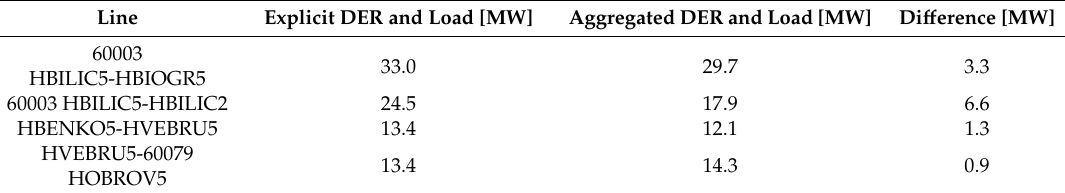
Table 7. Load flow calculation comparison